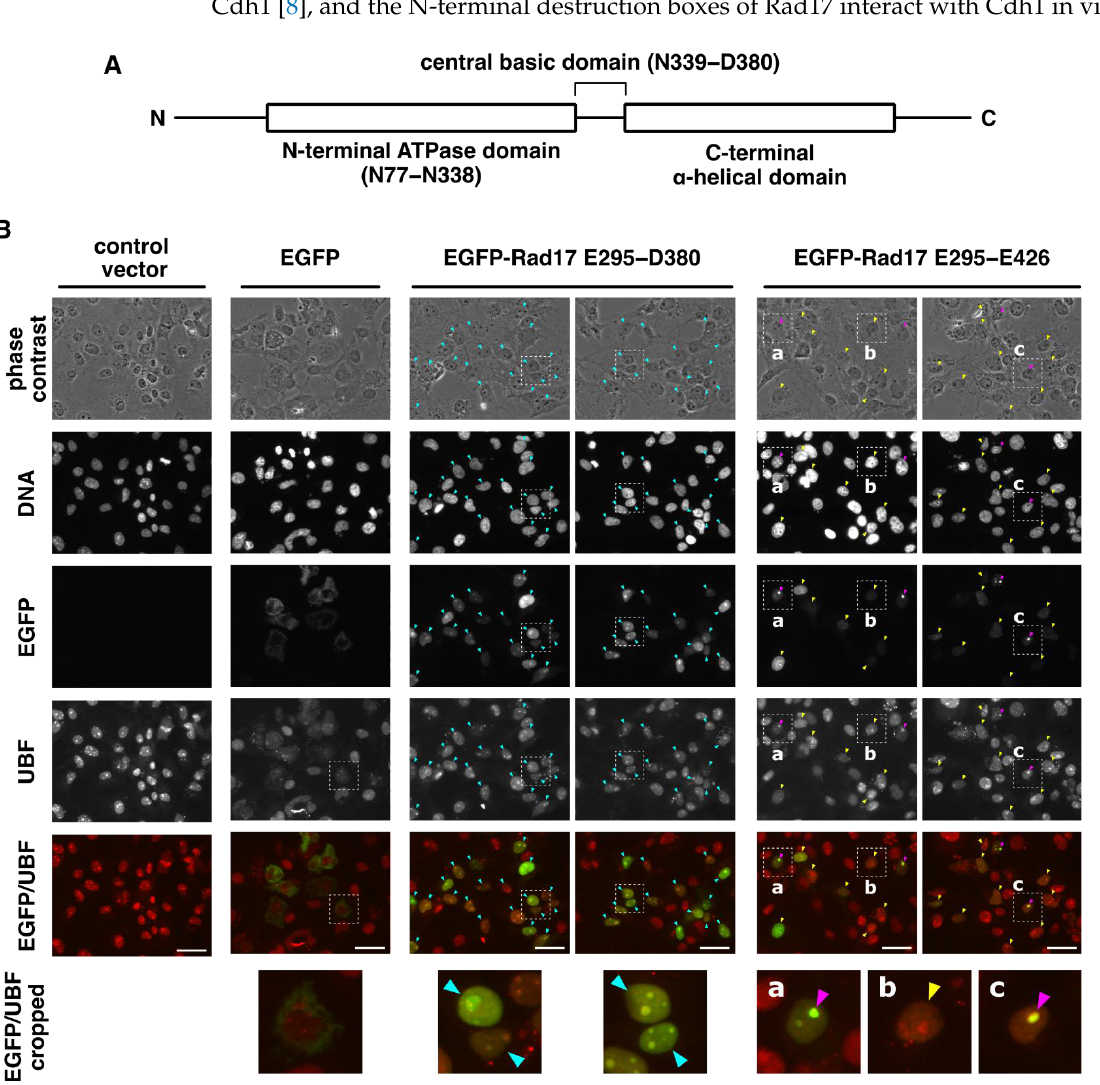
Figure 1. The central basic domain of Rad17 encodes a nucleolar localization signal. ( A ) The central basic domain resides between the N-terminal ATPase domain and the C-terminal α -helical domain. The domain structure of human Rad17 is shown (isoform 1. NCBI NP_579921.1. 670 amino acids). ( B ) EGFP fused with Rad17 E295 ‒ D380 and E295‒E426 peptid es was localized in the nucleus and predominantly accumulated in the nucleolus. COS-7 cells were transfected with plasmid vectors expressing EGFP fused with Rad17 E295 ‒ D380 or E295 ‒ E426 peptide. The cells were fixed and stained with anti-UBF antibody and Hoechst 33342. Arrowheads indicate cells in which the EGFP signal was localized in the following manners: cyan, in the nucleus and predominantly accumulated in the nucleolus; magenta, in the nucleolus; yellow, in both nucleus and nucleolus. Representative results of two independent experiments are shown. The ratios of cells with the magenta arrowhead to all EGFP-positive cells were 34% and 22% in each experiment. Approximately 100 cells were ob- served in each experiment. Scale bars are 40 μm.